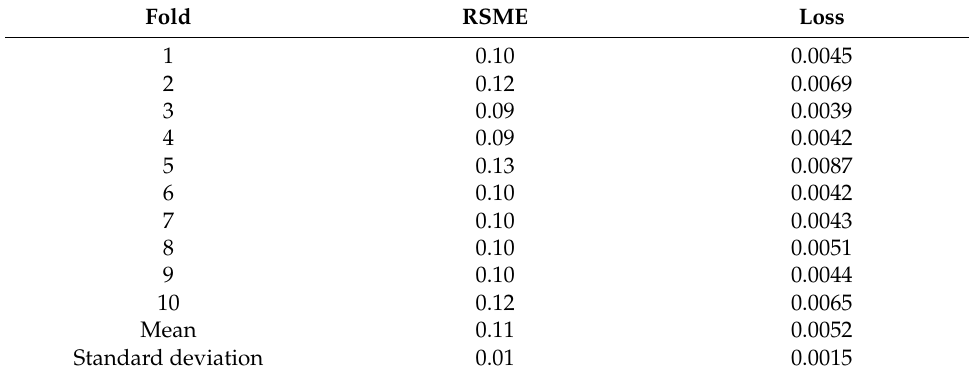
Table 3. Results of the 10-fold cross-validation.